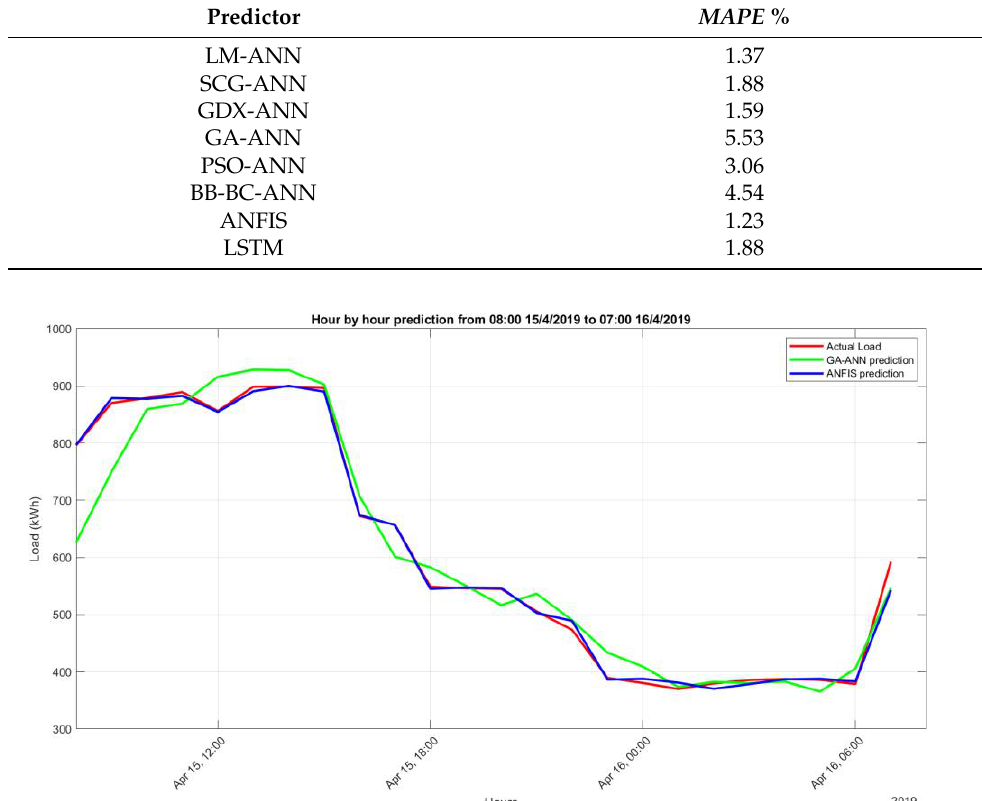
Figure 15. ANFIS and GA-ANN 24-h predictions and actual loads.